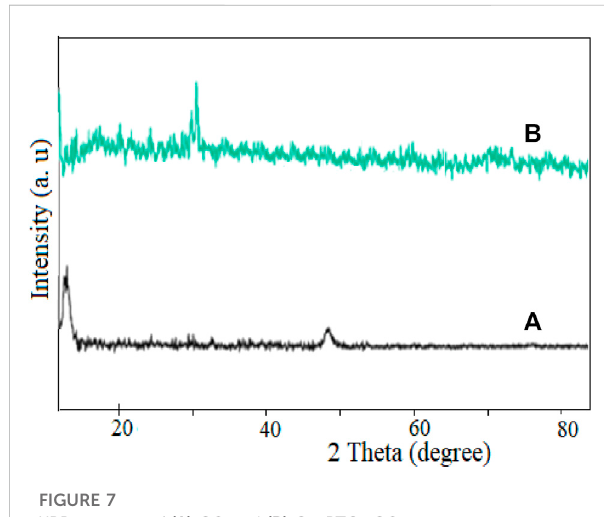
FIGURE 7 XRD patterns of (A) GO and (B) Cu-PTC@GO.